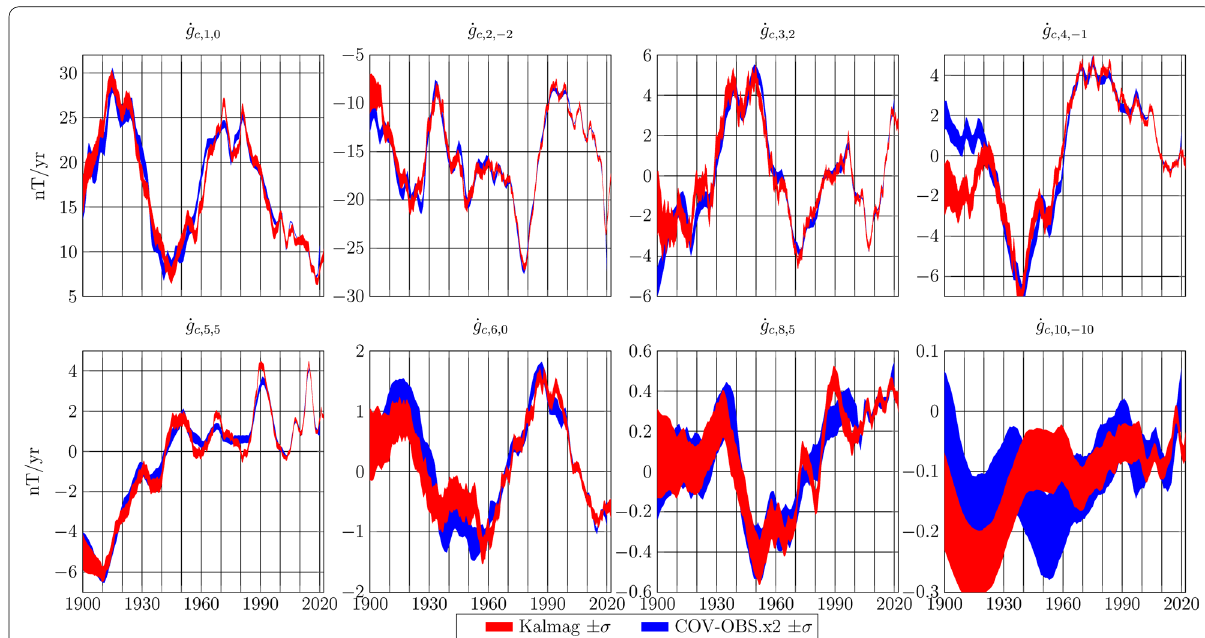
Fig. 4 Time series between 1900 and 2022 of selected spherical harmonics coefficients (indicated on the top of each panel) of the secular variation at the Earth’s surface. 68.2% confidence interval of the Kalmag solution (red areas) and the COV‑OBS.x2 solution (blue areas) of Huder et al. (2020)